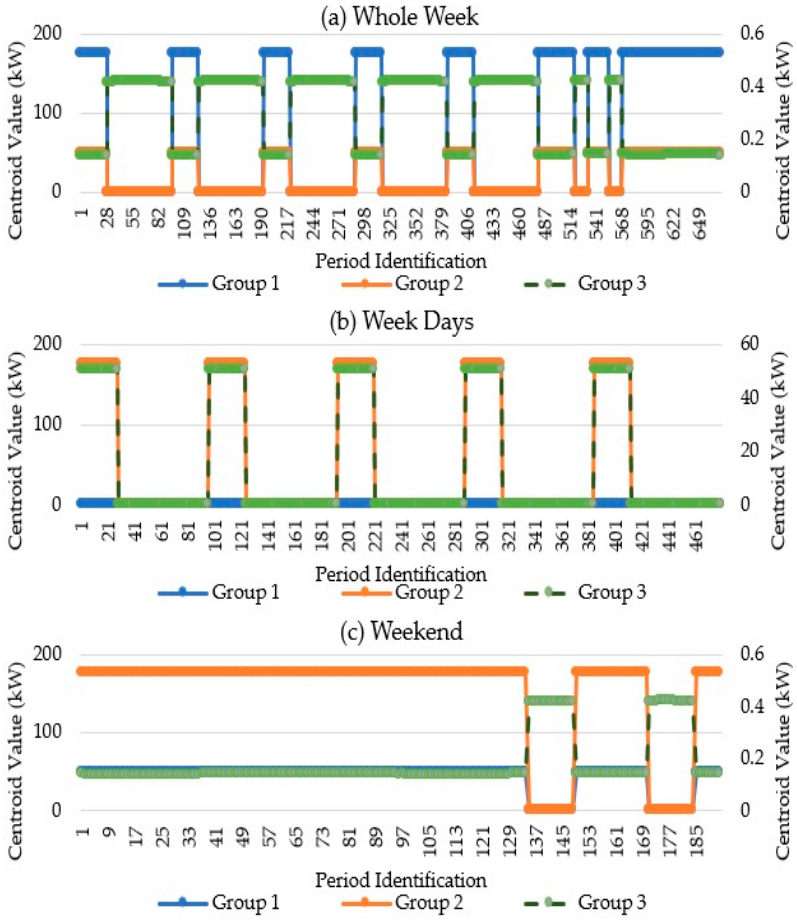
Figure 6. Centroid value. ( a ) Results for the whole week scenario; ( b ) results for the week days scenario; ( c ) results for the weekend scenario.